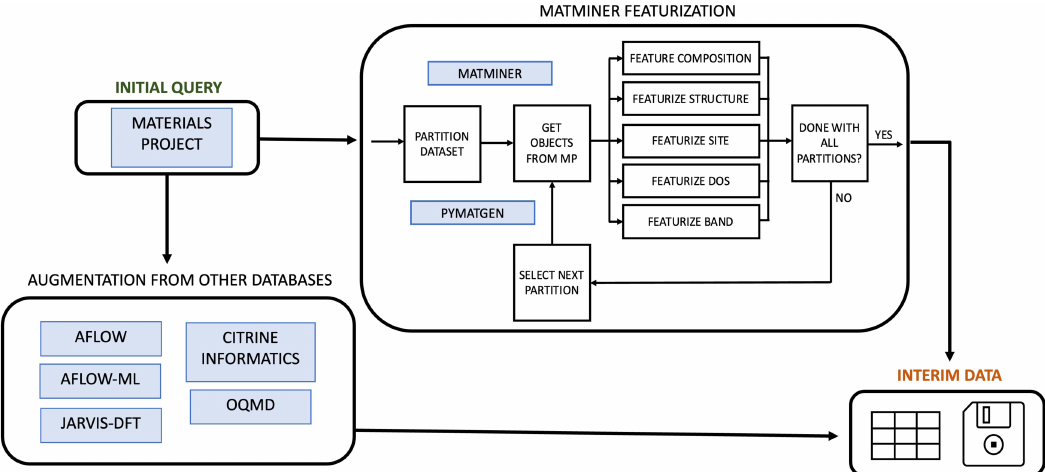
Fig. 2 Featurization work fl ow. The project work fl ow starting from an initial Materials Project (MP) query, and ending with a featurized dataset with entries from several other databases. To limit the memory and computational usage, the data is partitioned into smaller subsets where the respective Pymatgen objects (Pymatgen is a robust, open-source Python library for materials analysis 69 ) are obtained through a query to be used in the following featurization steps. This process is repeated iteratively until all the data has been featurized. DOS refers to density of states and band to the electronic band